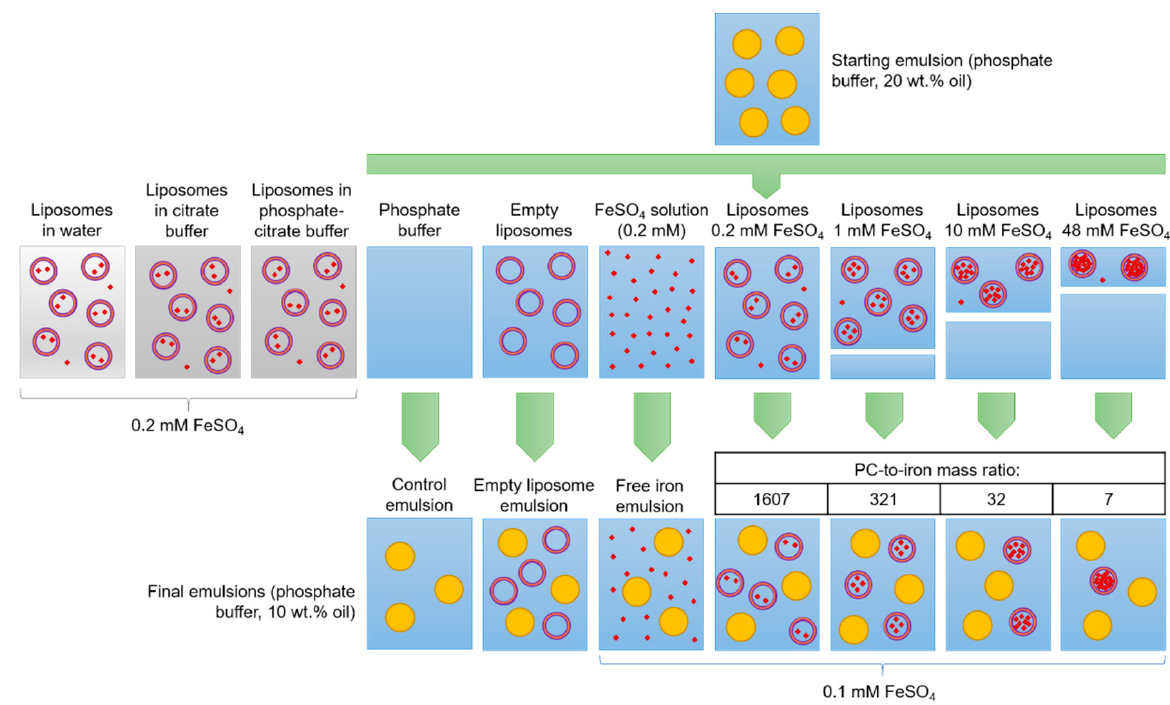
Figure 1. Schematic view of the preparation of emulsions that may or may not contain iron and/or liposomal material. The blue background corresponds to phosphate buffer, yellow spheres represent oil droplets, purple circles represent the liposomes, and small red dots represent soluble iron (not to scale). PC, phosphatidylcholine.